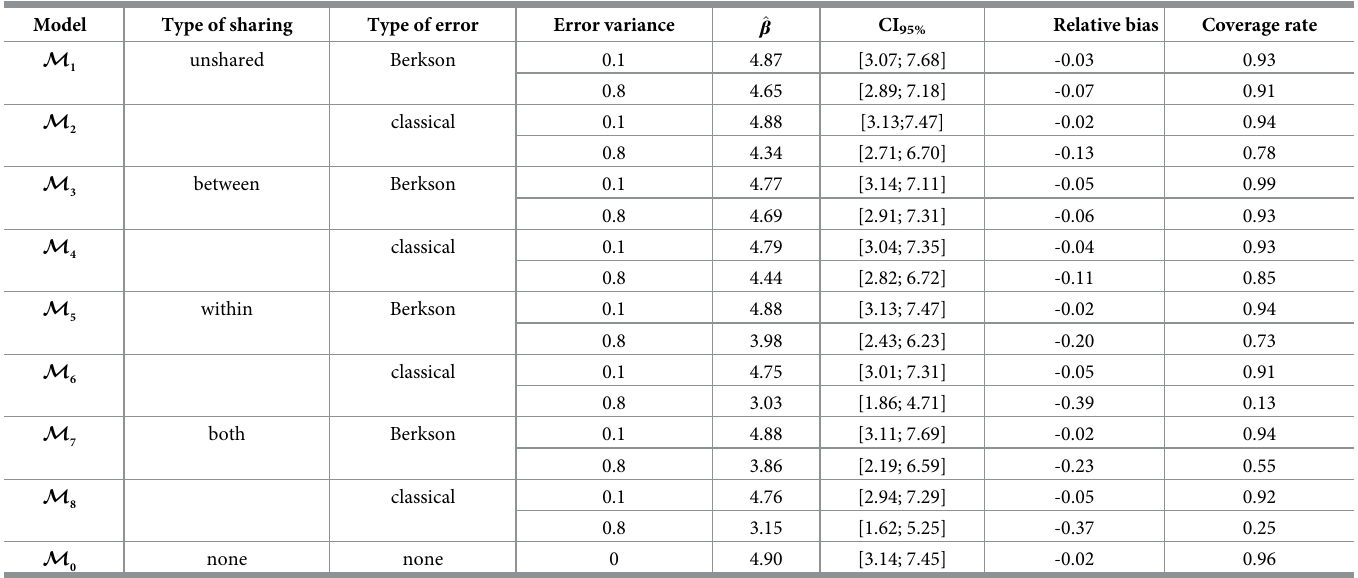
Table 2. Average posterior median ( ^ β ), overall 95% credible intervals (CI 95% ), relative bias and coverage rate for 100 data sets generated according to the EHR model